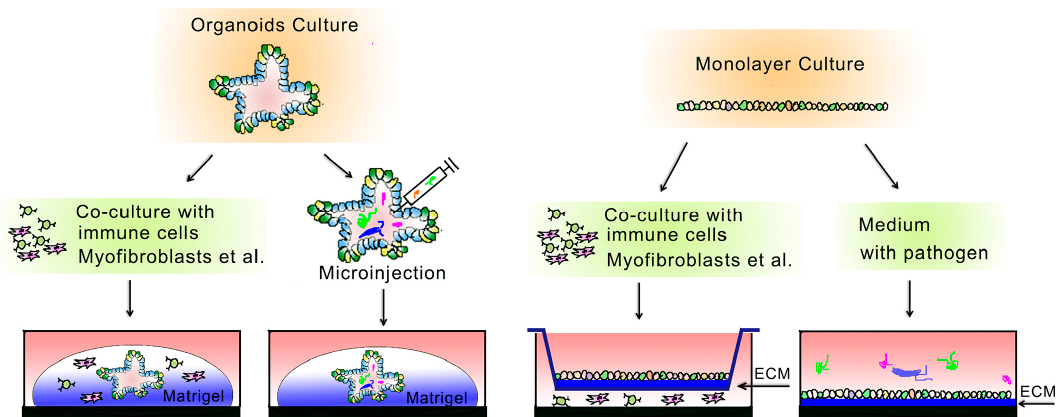
Figure 2. Models for intestinal epithelium-niche cells and epithelium–microbes/pathogen interactions. Both the 3D organoid culture and the transwell-based 2D monolayer culture can be used for the investigation of intestinal epithelium–niche cell interactions. To study the epithelium–microbe/pathogen interactions, microbes and pathogens can be introduced directly into the culture medium of 2D monolayer systems, while for the 3D cultures, pathogens need to be injected into the lumen of organoids to allow them to come into contact with the apical side of the epithelium.